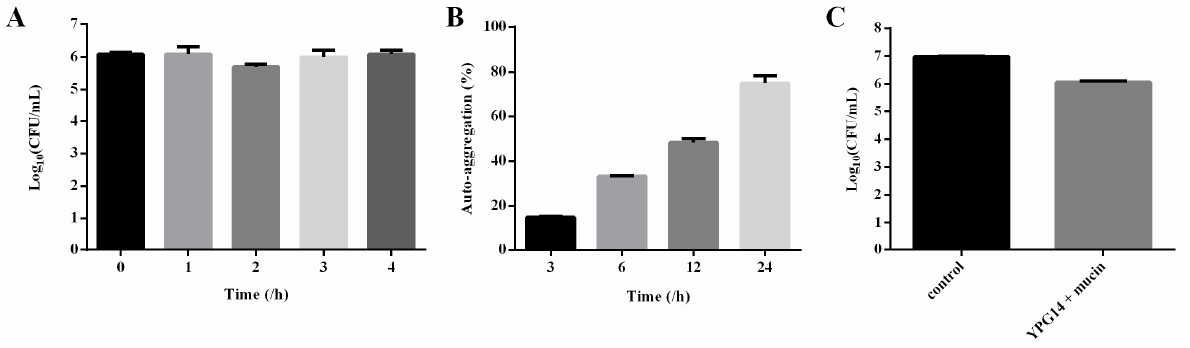
Figure 6. The characterization of partial probiotic properties of the strain YPG14. ( A ) The tolerance of the strain YPG14 to simulated intestinal juice; ( B ) The auto-aggregation percentage of the strain YPG14; ( C ) The adhesion of the strain YPG14 to mucin.